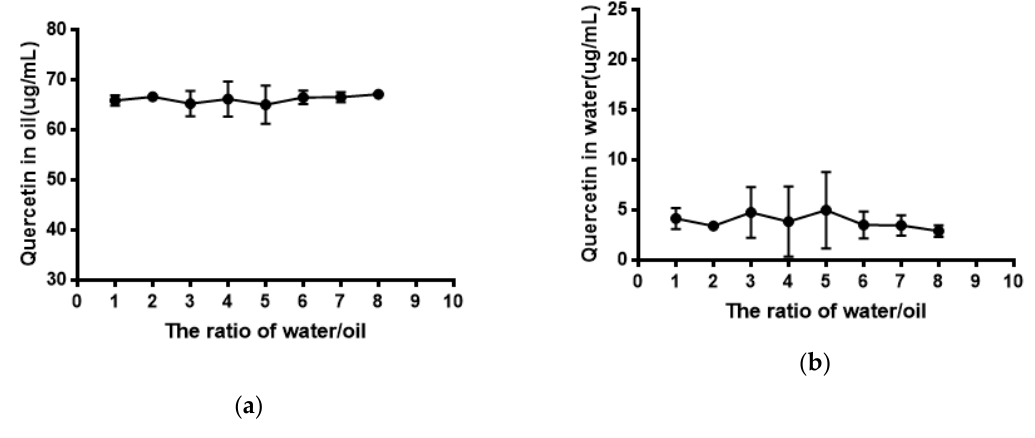
Figure 5. Solubility of quercetin in water and phosphate buffers.